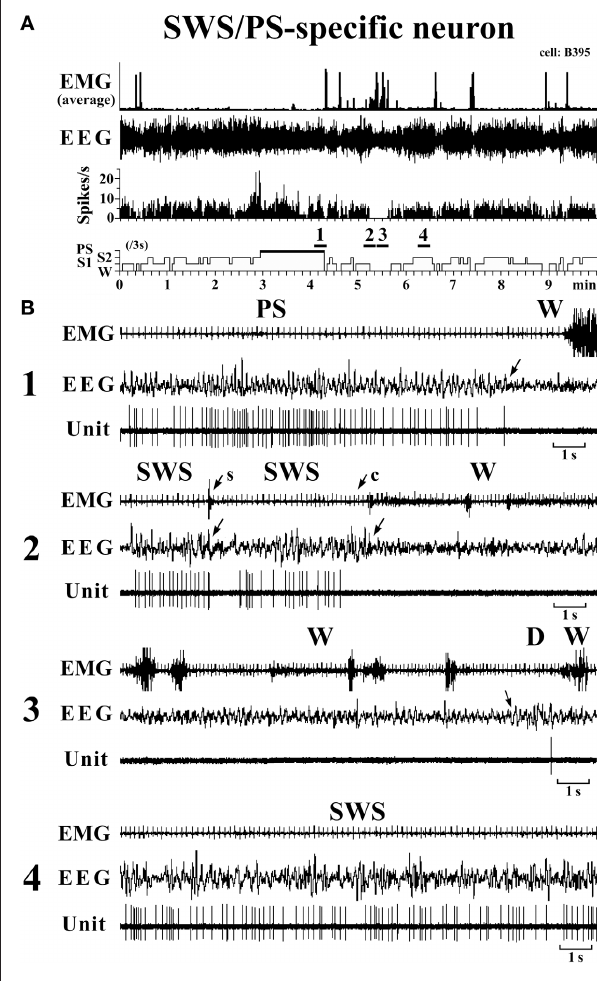
Figure 6 | Activity of a VTM SWS/PS-specific neuron across the sleep-waking states. The arrows indicate the state transitions. The arrows with “s” or “c” indicate W elicited by an sound stimulus or removing the cover placed over the head of the mouse, respectively. The four traces in (B) are from the periods indicated by the bar under, respectively, “1”, “2”, “3”, and “4” in (A)